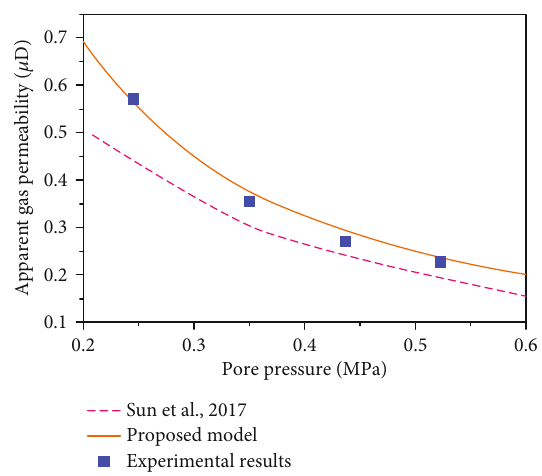
Figure 3: Validation of the proposed model for gas transport through organic pores.